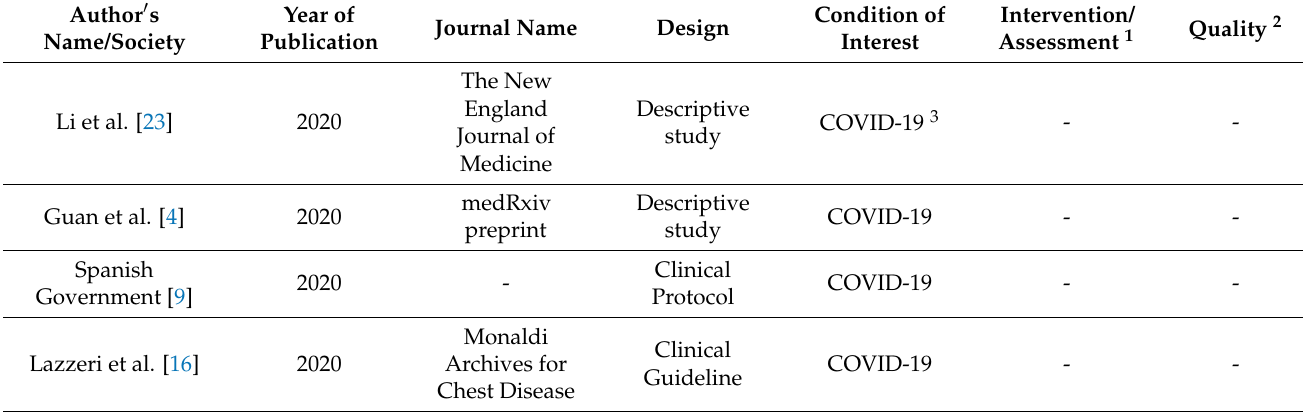
Table 1. Studies characteristics and quality assessment.